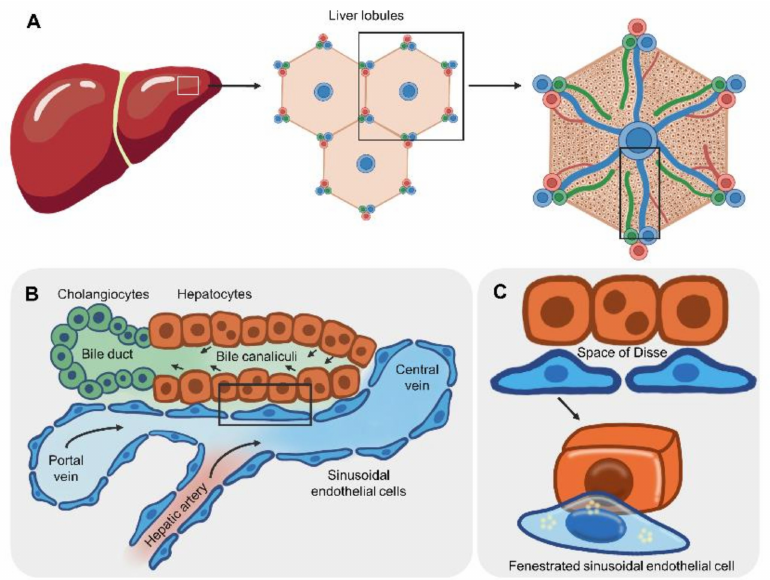
Figure 1. Microarchitecture and cellular compartments of liver lobules. ( A ) The liver lobule is a hexagon-shaped unit that combines with other lobules to comprise the complete liver structure. The central vein is located at the center of each liver lobule. The apical side of the hexagon consists of the hepatic artery, hepatic portal vein and bile duct (portal triad). ( B ) Hepatic cells radially surround the central vein (rectangle from panel ( A )). Blood flows from the hepatic portal vein to the central vein and passes through a single layer of sinusoidal endothelial cells (SECs). The apical side of adjacent hepatocytes forms bile canaliculi, where bile acid is secreted and transported to the bile duct, the walls of which are lined by cholangiocytes. ( C ) Fenestration of SECs (rectangle from panel ( B )) allows noncellular fluid to reach the perisinusoidal space (space of Disse), where the basolateral side of hepatocytes is exposed to nutrients, gases and chemical